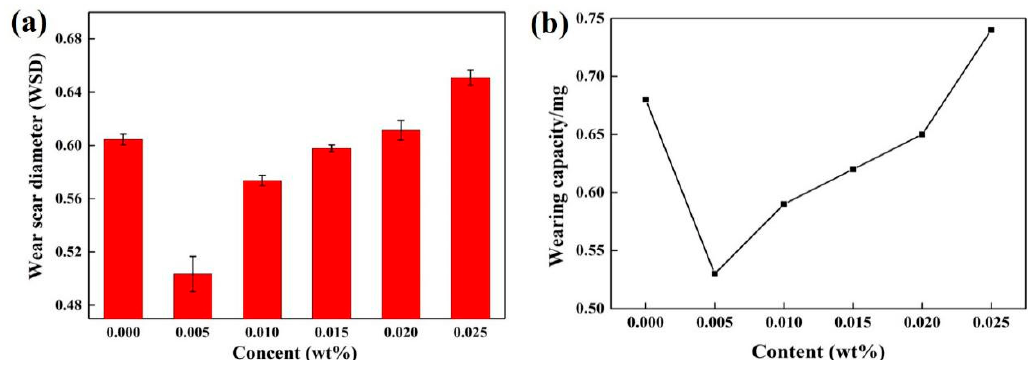
Figure 6. Wear scar diameter ( a ) and wearing capacity ( b ) of ML-MSH/CGB oil as a function of added content.